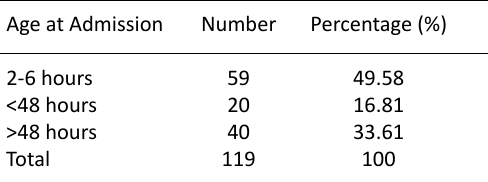
Table 2. Distribution of the place and mode of delivery of the suspected septic neonates (n=119) Mode of